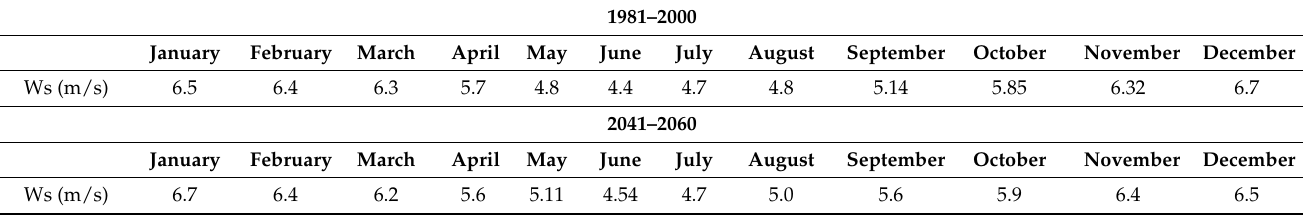
Figure 5. Hourly relative humidity evolution for the typical mean days of each month and for the periods 1981–2000 and 2041–2060. Table 2. Daily average wind speed for the mean typical days of each month and simulation period, used in ENVI-met microclimate simulations.